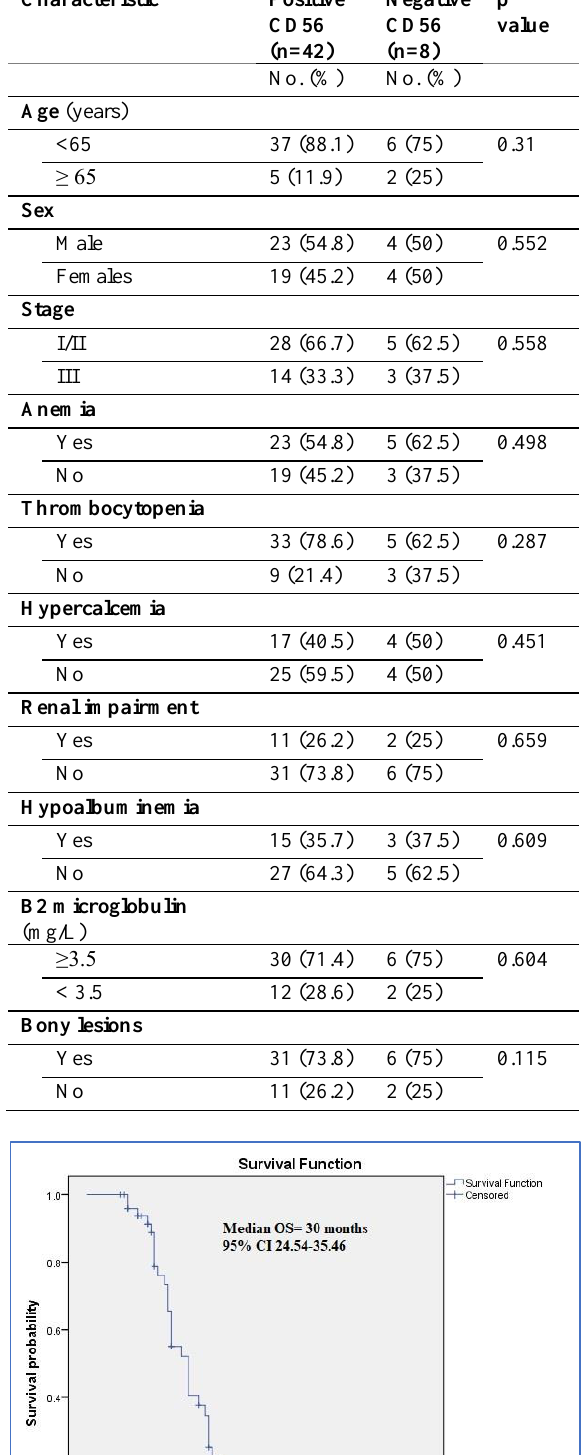
Table 3: Univariate analysis of overall survival in 50 patients with multiple myeloma